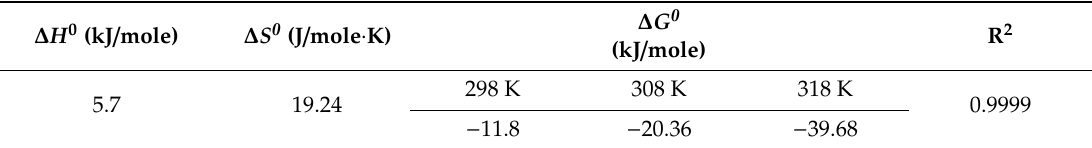
Table 2. Thermodynamic parameters for adsorption of silver onto